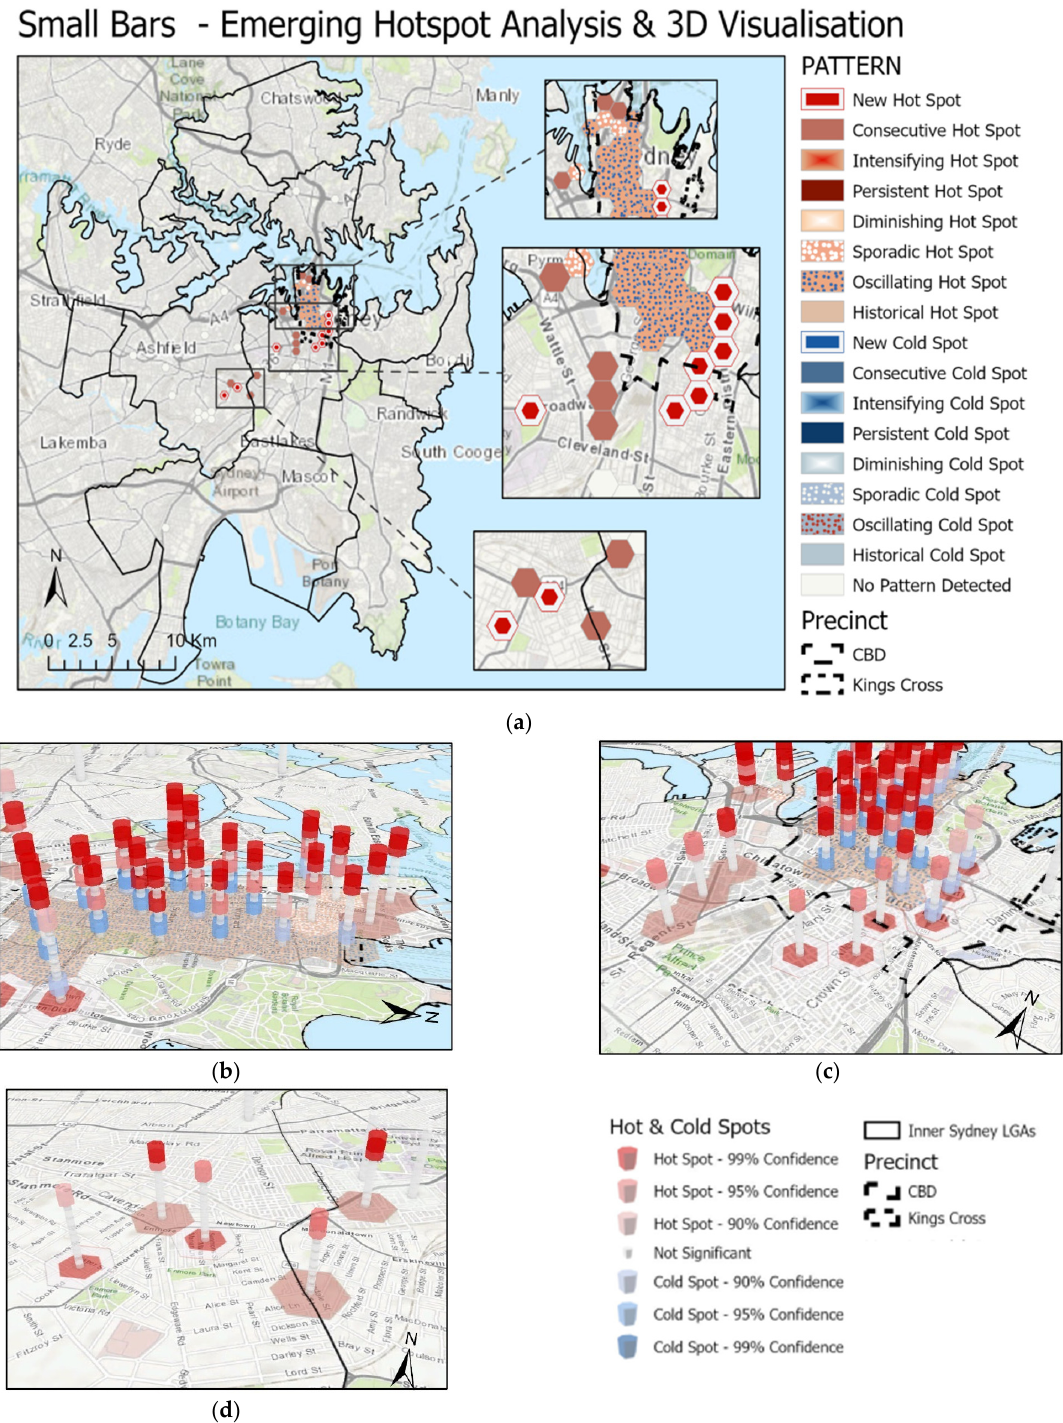
Figure 16. ( a ) Small bar spatio ‐ temporal analysis 2012–2021; ( b ) Small bar space ‐ time cube 3D visualisation northern CBD; ( c ) Small bar space ‐ time cube 3D visualisation southern CBD; ( d ) Small bar space ‐ time cube 3D visualisation western section.